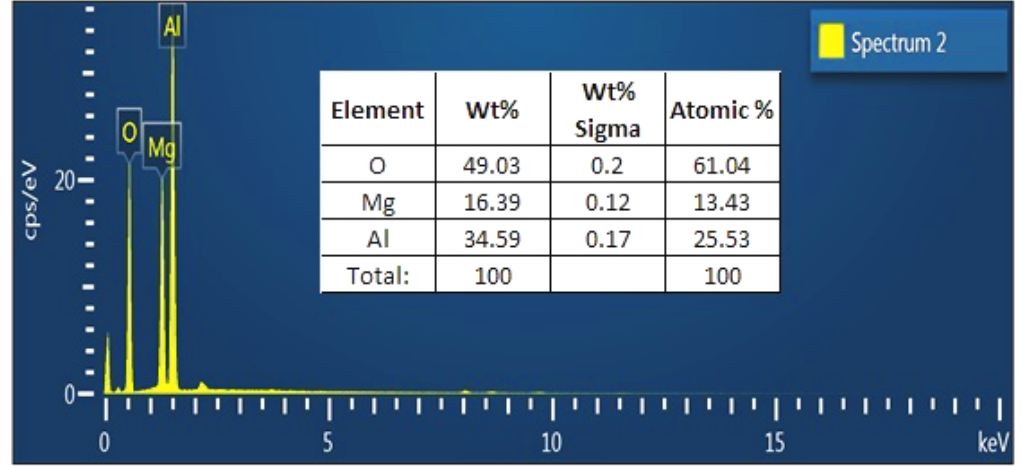
Figure 9. EDS of MgAl 2 O 4 NPs.